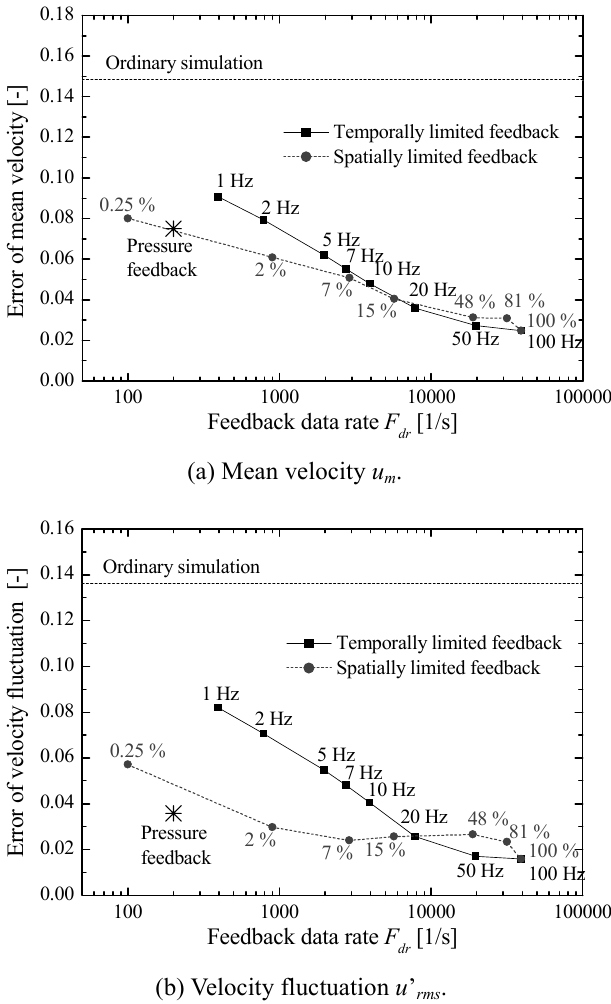
Fig. 6 Mean error in streamwise velocity against feedback data